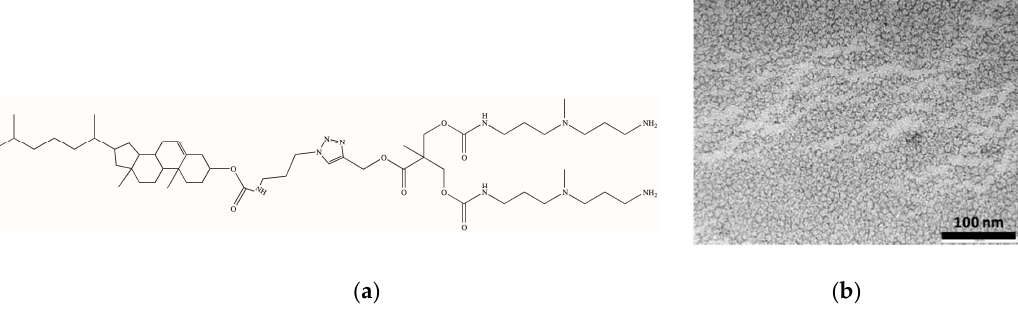
Figure 14. ( a ) Structure of the amphiphilic dendron CholSG 1 . ( b ) TEM images of the spherical micelles obtained upon self-assembling of CholSG 1 . Adapted from [29] with the permission of The Royal Society of